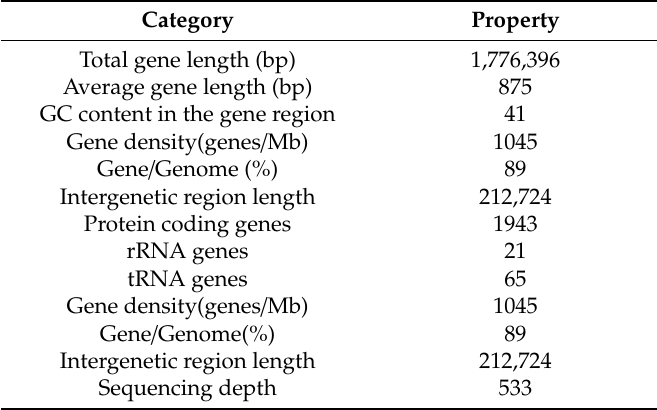
Figure 3. Phylogenetic tree of the L. sakei yak isolate and references strains. The tree was constructed using software MEGA 6.0 by the neighbor-joining method, based on 16S rDNA gene sequences with 1000 replications in bootstrap testing. Table 3. Statistical results of the gene prediction of L. sakei.